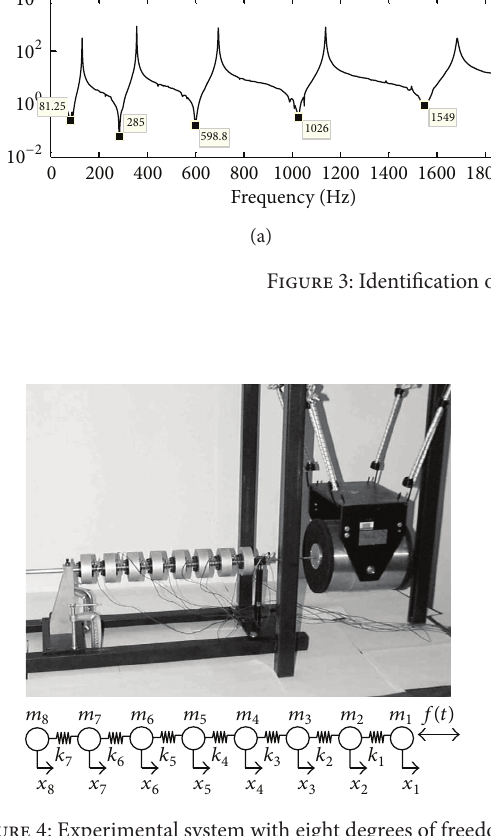
Figure 4: Experimental system with eight degrees of freedom.